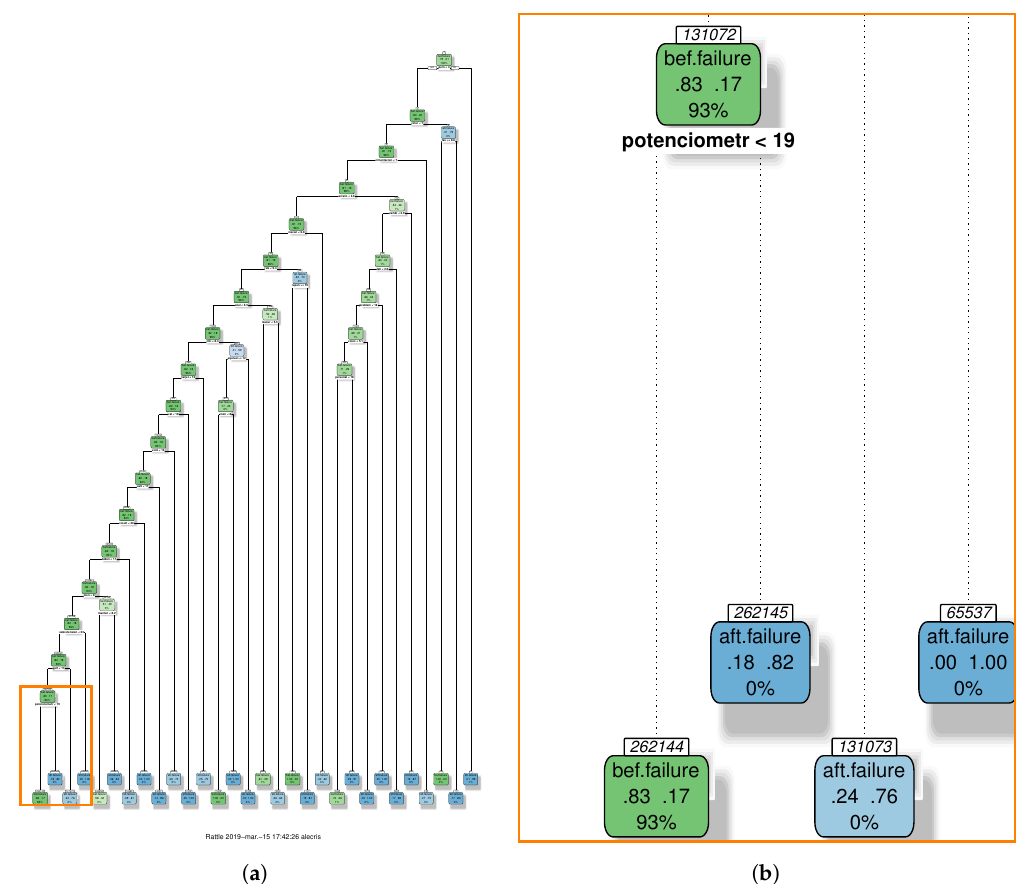
Figure 8. Decision Tree result for the gearbox failures ( a ). The model was generated with the words that have a frequency from 1% to 90%. This range is a good trade-off for each of the metrics of Figure 7. The zoomed panel ( b ) shows that with only the word potenciometr almost the 93% of the observations are classified as “before